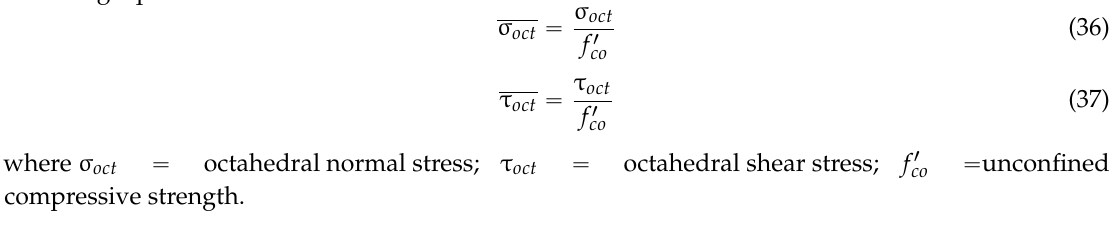
Table 3. Surface meridians’ control point